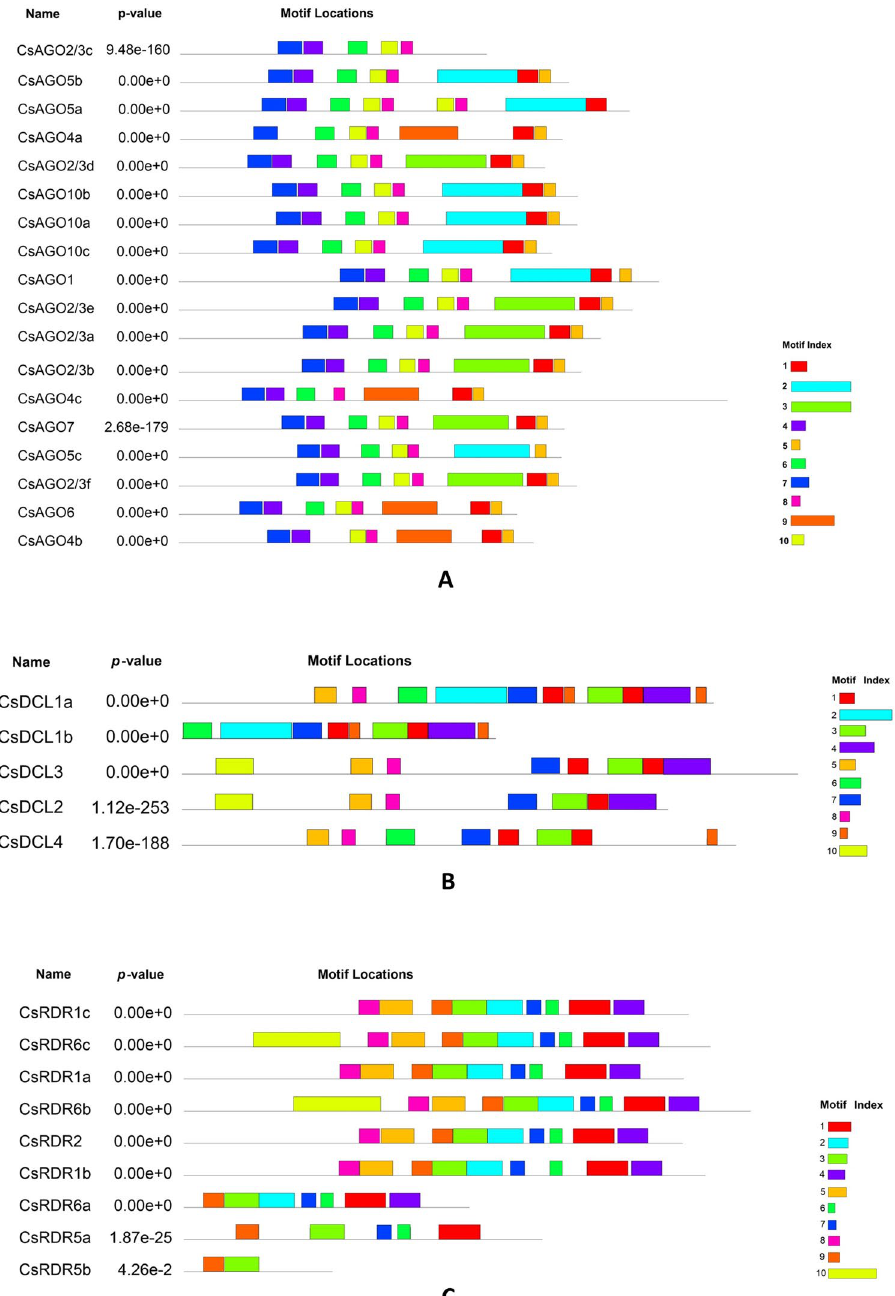
Figure 5. Distribution of conserved motifs identified in proteins encoded by ( A ) CsAGOs , ( B ) CsDCLs and ( C ) CsRDRs . The motif index represents the corresponding motif number depicted in Supplementary Figure S3 and Supplementary Table S2 for motif